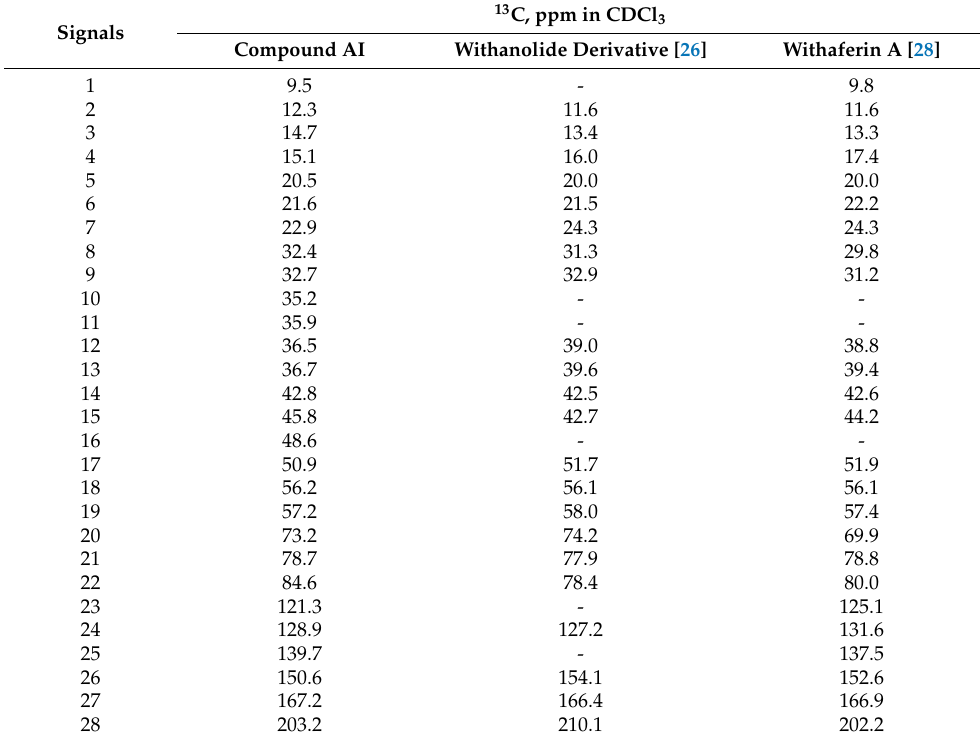
Table 11. 13 C-NMR chemical shifts of compound AI showing similarities with the reported literature data